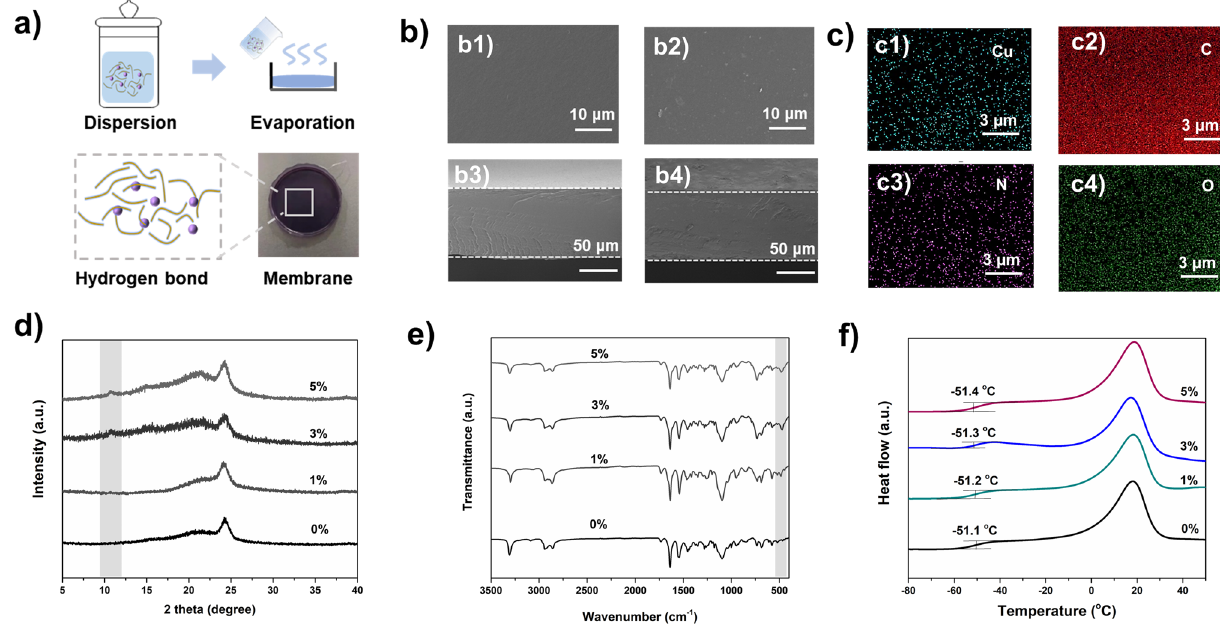
Fig. 3 a Schematic of membrane construction. b Top-section SEM images of Pebax ( b1 ) and MMMs ( b2 ), the cross section membrane SEM images of Pebax ( b3 ) and MMMs ( b4 ). c EDS mapping of MMM ( c1 for Cu, c2 for C, c3 for N, c4 for O). d XRD pattern, e FTIR spectra and f DSC analysis of the MMMs with the filler content of 0, 1, 3, and 5